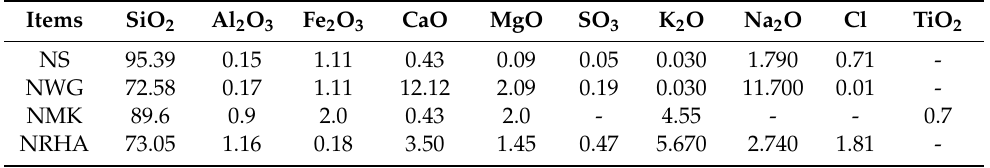
Table 3. Chemical composition of NS, NWG, NRHA, and NMK